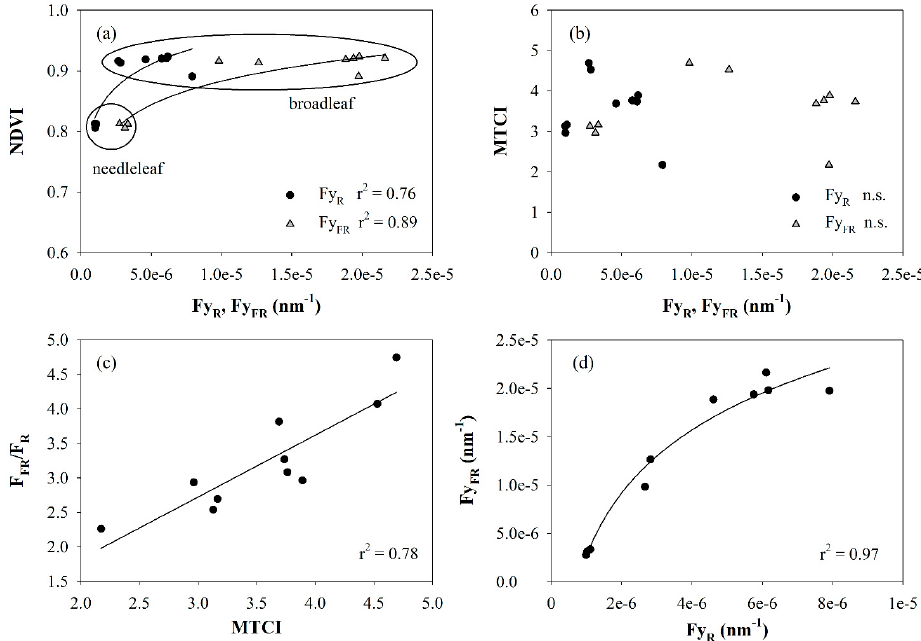
Figure 5. Measured data. Relationships between: ( a ) Fy R , Fy FR and NDVI; ( b ) Fy R , Fy FR and MTCI; ( c ) F FR /F R ratio and MTCI; and ( d ) Fy R and Fy FR . Each point indicates the half-hourly average value measured between 11:00 a.m. and 1:00 p.m. local solar time.